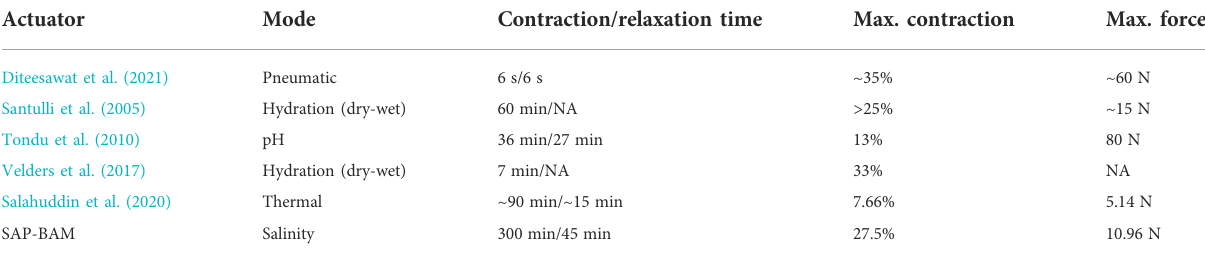
TABLE 1 Comparison of the actuation parameters of existing encapsulated-hydrogel actuators and the pneumatic BAM against the current work. Where values were not mentioned directly in the text of the referenced work, they have been estimated from available fi gures. Actuator Mode Contraction/relaxation time Max.